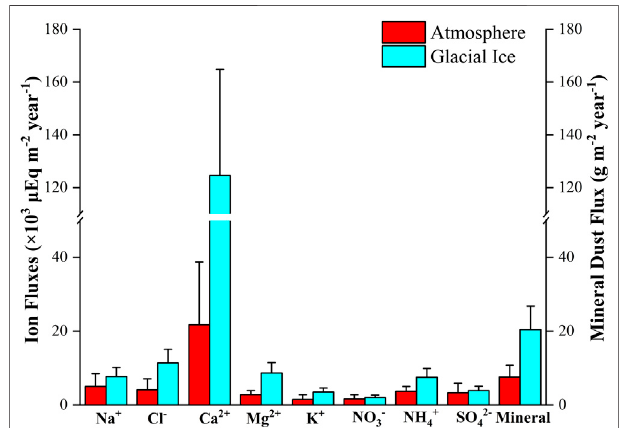
FIGURE 5 | Annual fl uxes of chemical solutes and mineral dust (d > 5 μ m) from the atmosphere and from the glacial ice estimated by ice cores analyzed in this